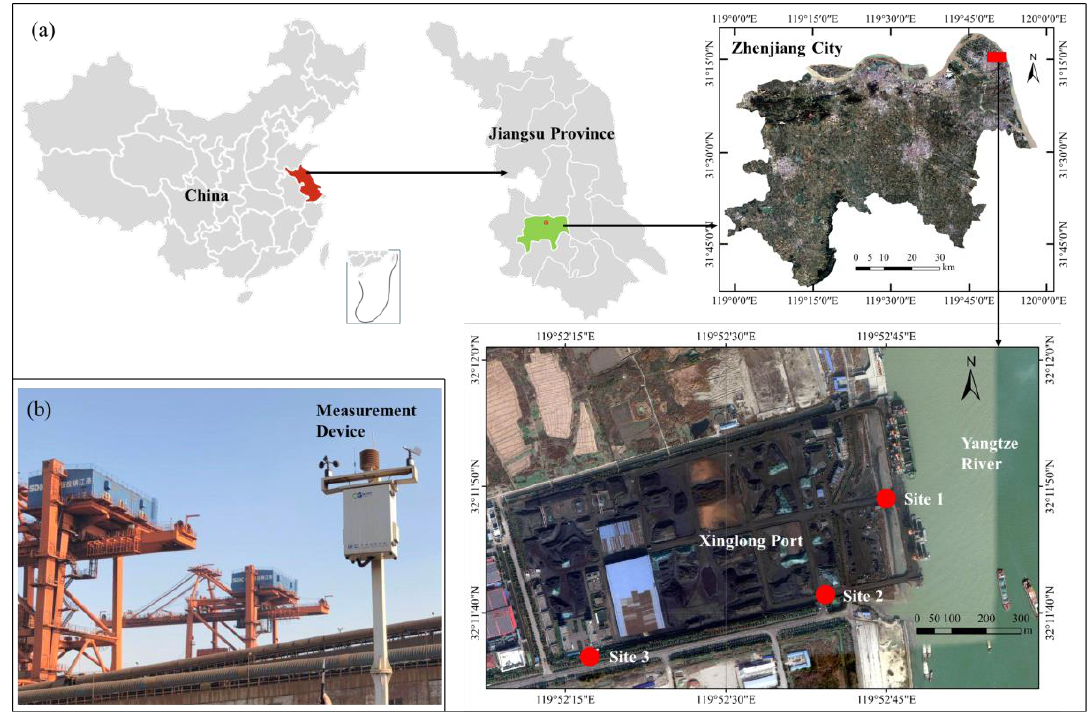
Figure 1. Study area and measurement device: ( a ) location of the city of Zhenjiang and the port of Xinglong; ( b ) installation of the measurement device.